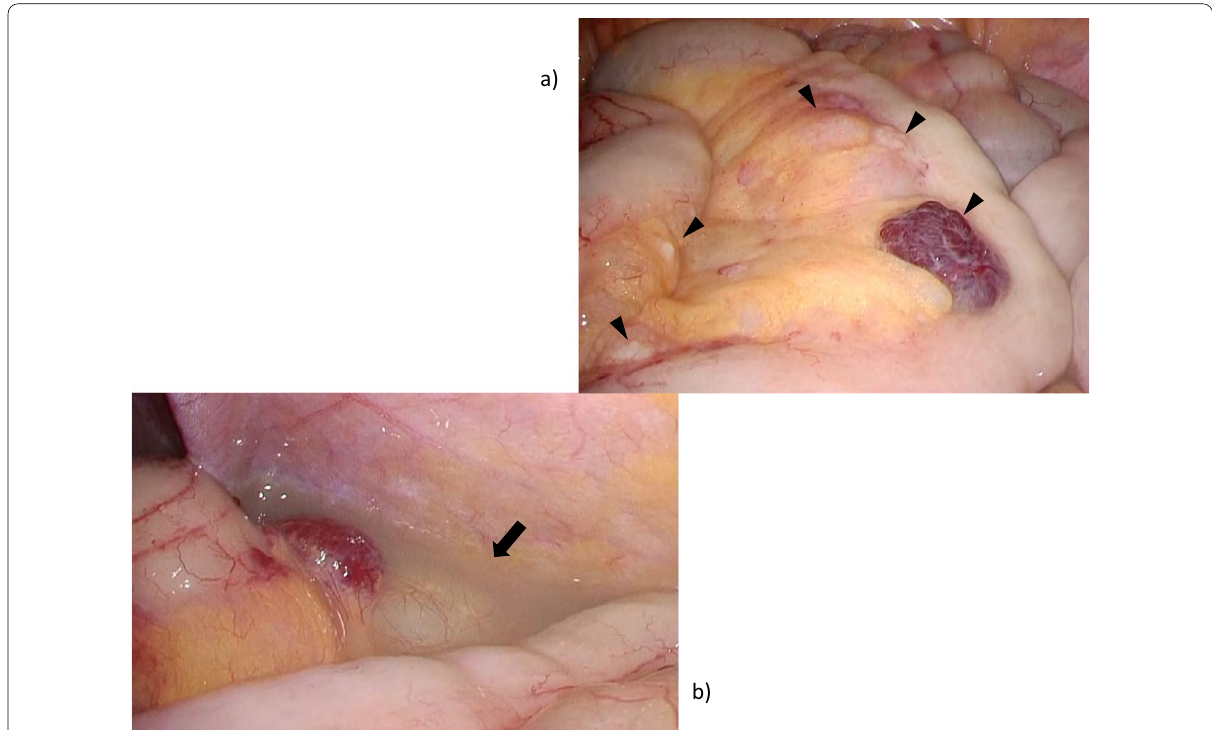
Fig. 5 Operative findings: a array of yellowish, cystic lesions and hemangiomatous tumors dispersed along small intestine and mesentery (arrowhead) and b small volume of grayish-white, slightly cloudy ascites